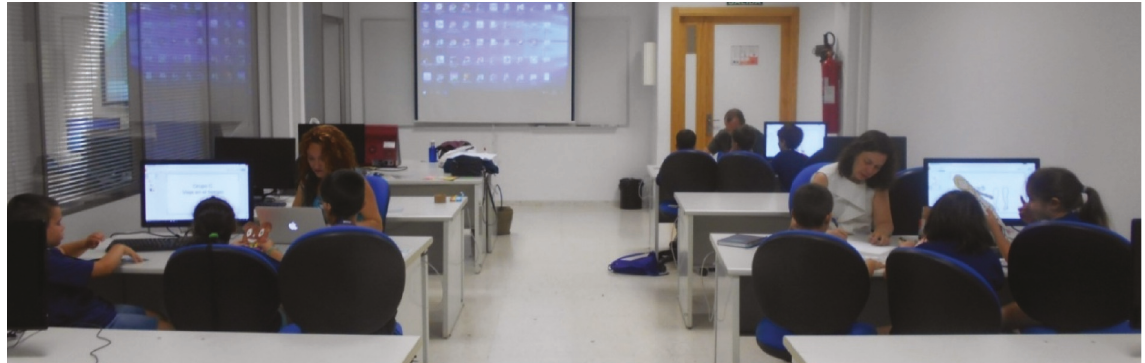
Figure 13: First intervention in a technological summer school (youngest